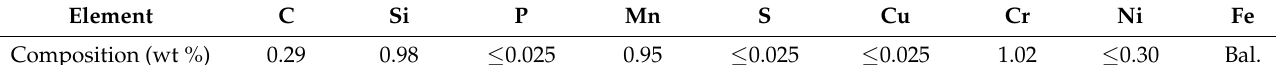
Table 1. Chemical compositions of the 30CrMnSiA high-strength steel.